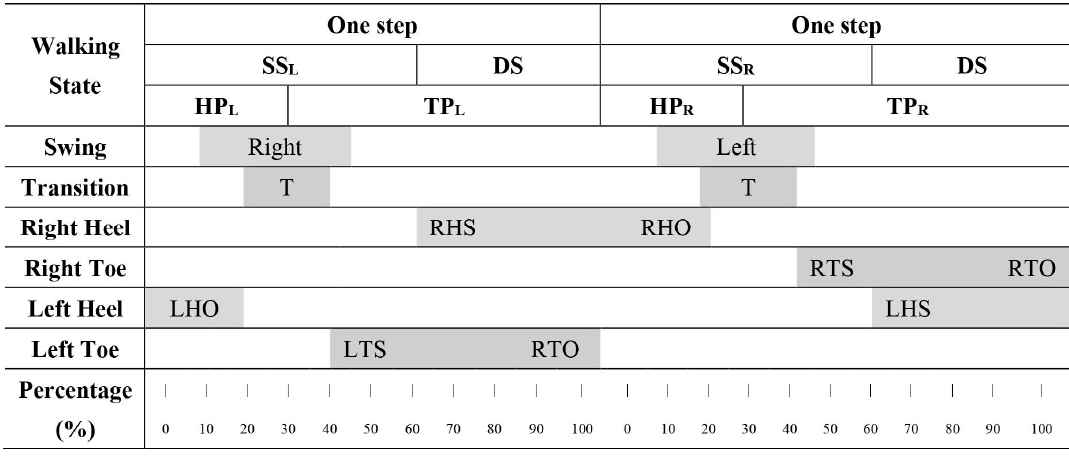
Figure 9. Walking state in two steps: one step is indicated as being from 0 to 100%.